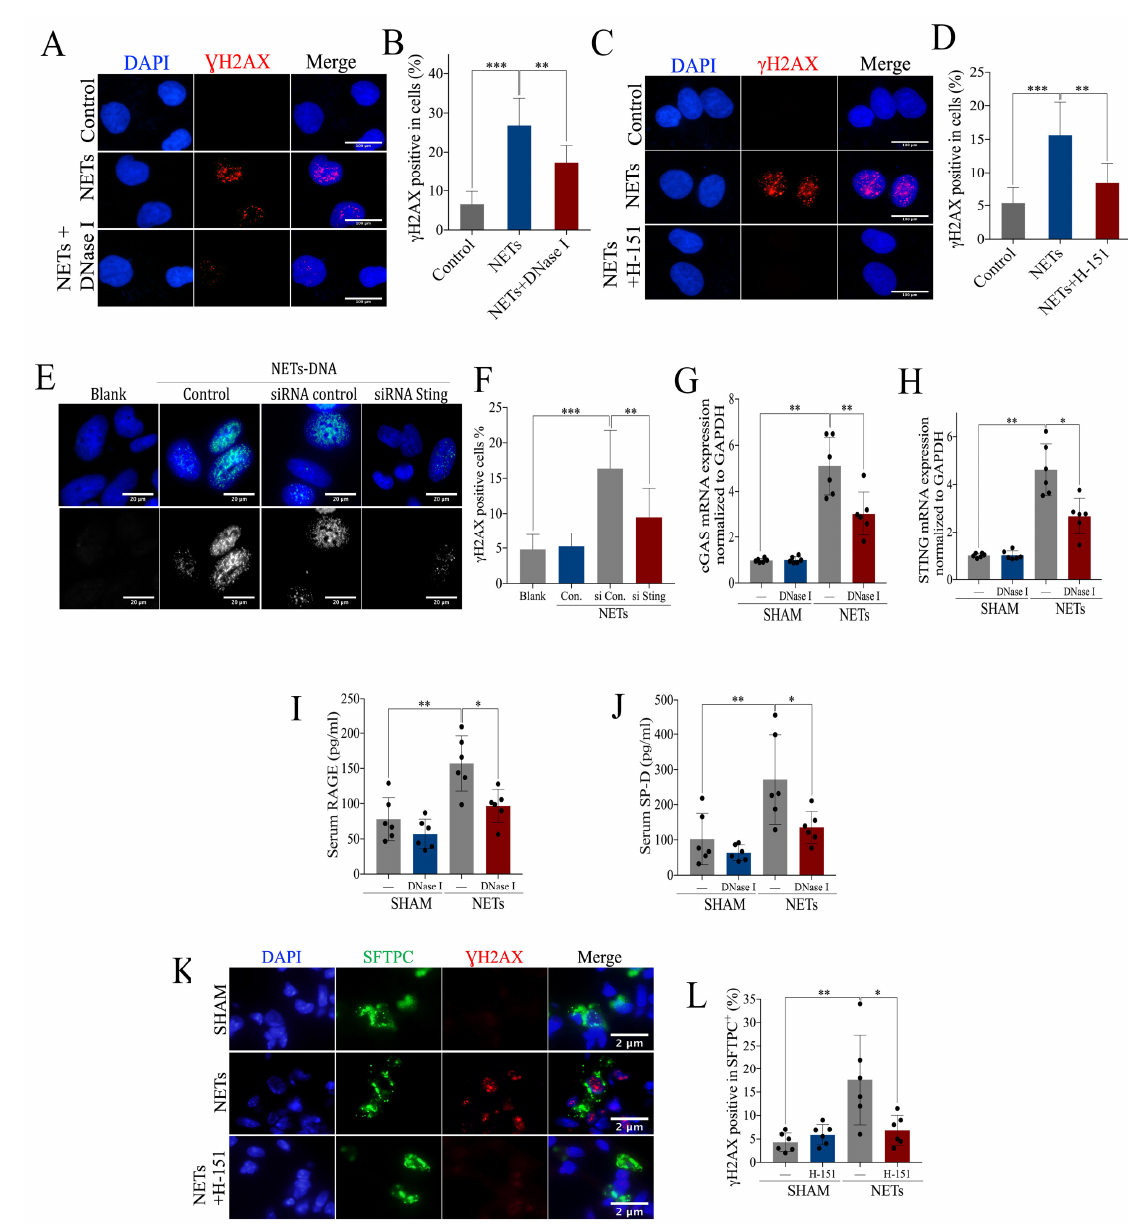
Figure 7. Intervention of exogenous NETs induces airway injury via cGAS-STING . ( A ) Representative images of immunofluorescence staining of γ H2AX in BEAS-2B cells pre-incubated with exogenous NETs and DNase I (Scale bar = 100 µ m ), and ( B ) statistics of the γ H2AX-positive cells. ( C ) Representative images of immunofluorescence staining of γH2AX in BEAS-2B cells pre-incubated with exogenous NETs and H-151 (Scale bar = 100 µ m), and ( D ) statistics of the γ H2AX-positive cells. ( E ) Representative images of immunofluorescence staining of γ H2AX in STING siRNA BEAS-2B cells pre-incubated with NETs (Scale bar = 20 µ m), and ( F ) statistics of the γ H2AX-positive cells. mRNA expression of ( G ) cGAS and ( H ) STING in lung tissue of mice administered with exogenous NETs and DNase I. Concentration of serum ( I ) RAGE and ( J ) SP-D, for mice administered with exogenous NETs and DNase I. ( K ) Representative images of immunofluorescence co-localization of γ H2AX and SFTPC (Scale bar = 2 µ m) and ( L ) the percentage of γ H2AX-positive SFTPC+ cells. Data are presented as the mean ± SD, n = 6 per group, * p < 0.05, ** p < 0.01, *** p < 0.001. Comparisons between two groups were analyzed by an unpaired t test; otherwise, one-way analysis of variance was performed, and Tukey’s test was used to perform pairwise